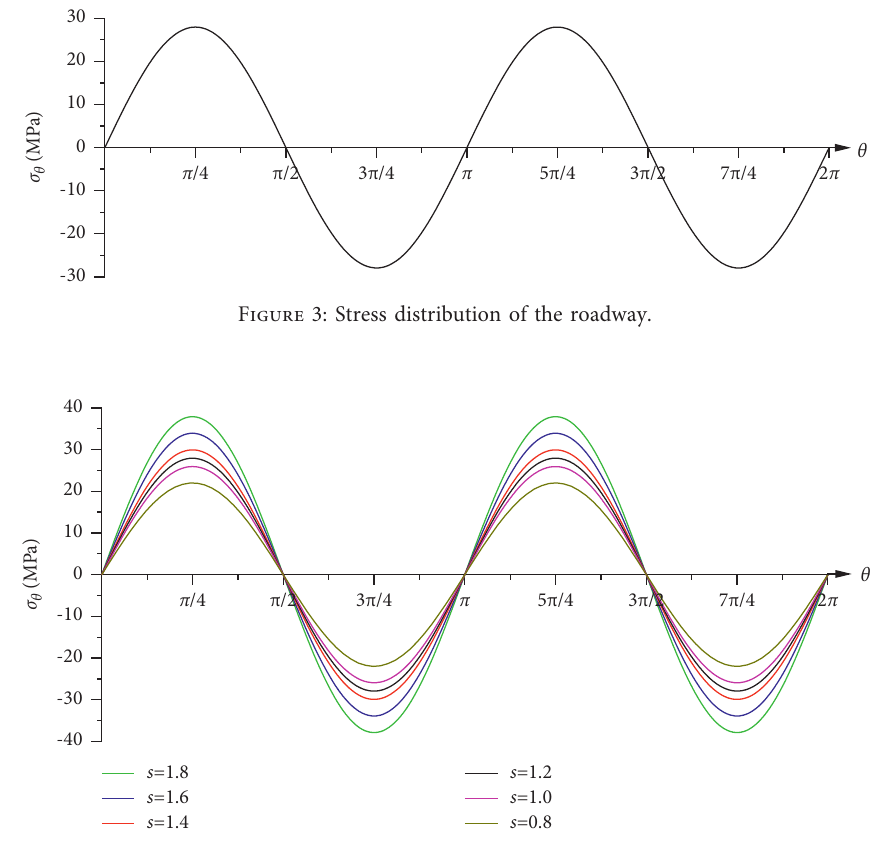
Figure 4: The stress distribution of the roadway with the change of lateral pressure coefficient. Table 1: Basic parameters of rock